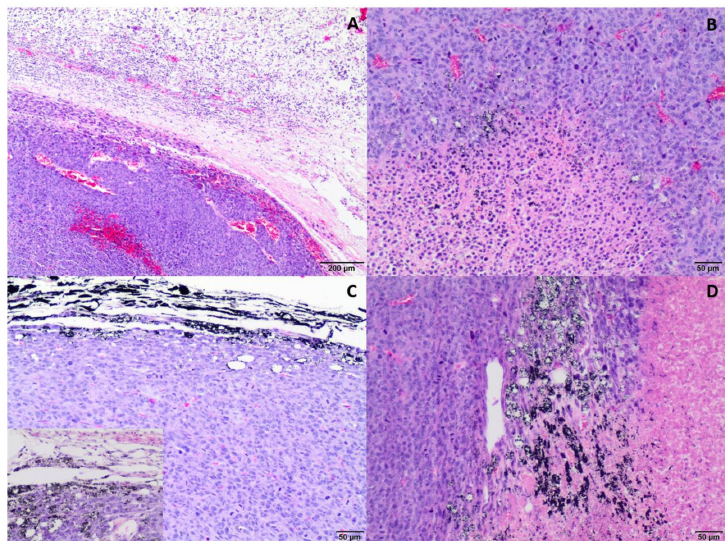
Figure 3. Representative images of feline injection site sarcoma (FISS) growth in immunodeficient mice. HE staining. Visible marked inflammatory infiltration in the periphery of the tumor ( A ) and the necrotic area in the tumor core ( B ). Au-GSH precipitate visible in Au-GSH-Dox-treated mice tumor periphery ( C ) and in the tumor core ( D ). Scale bar indicates 200 µ m ( A ), 50 µ m ( B – D ) and 20 µ m (insert).